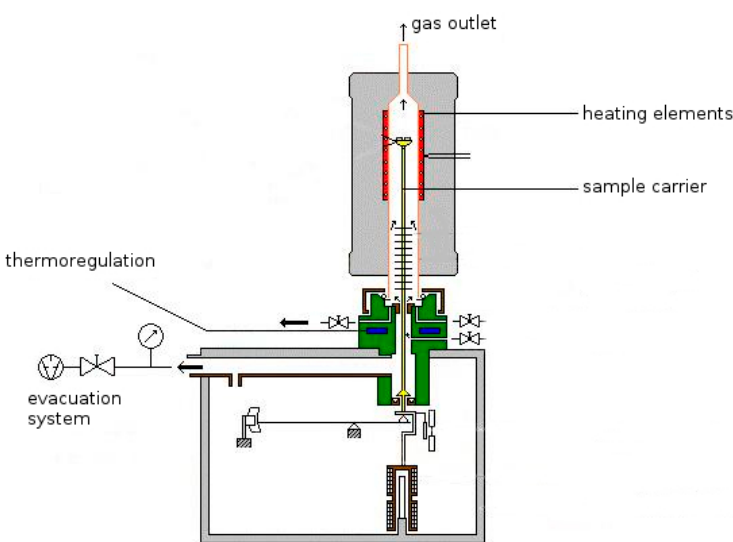
Figure 2. Schematic diagram of the apparatus NETZSCH STA 409. The gas outlet is directly coupled to the quadrupole mass-spectrometer.